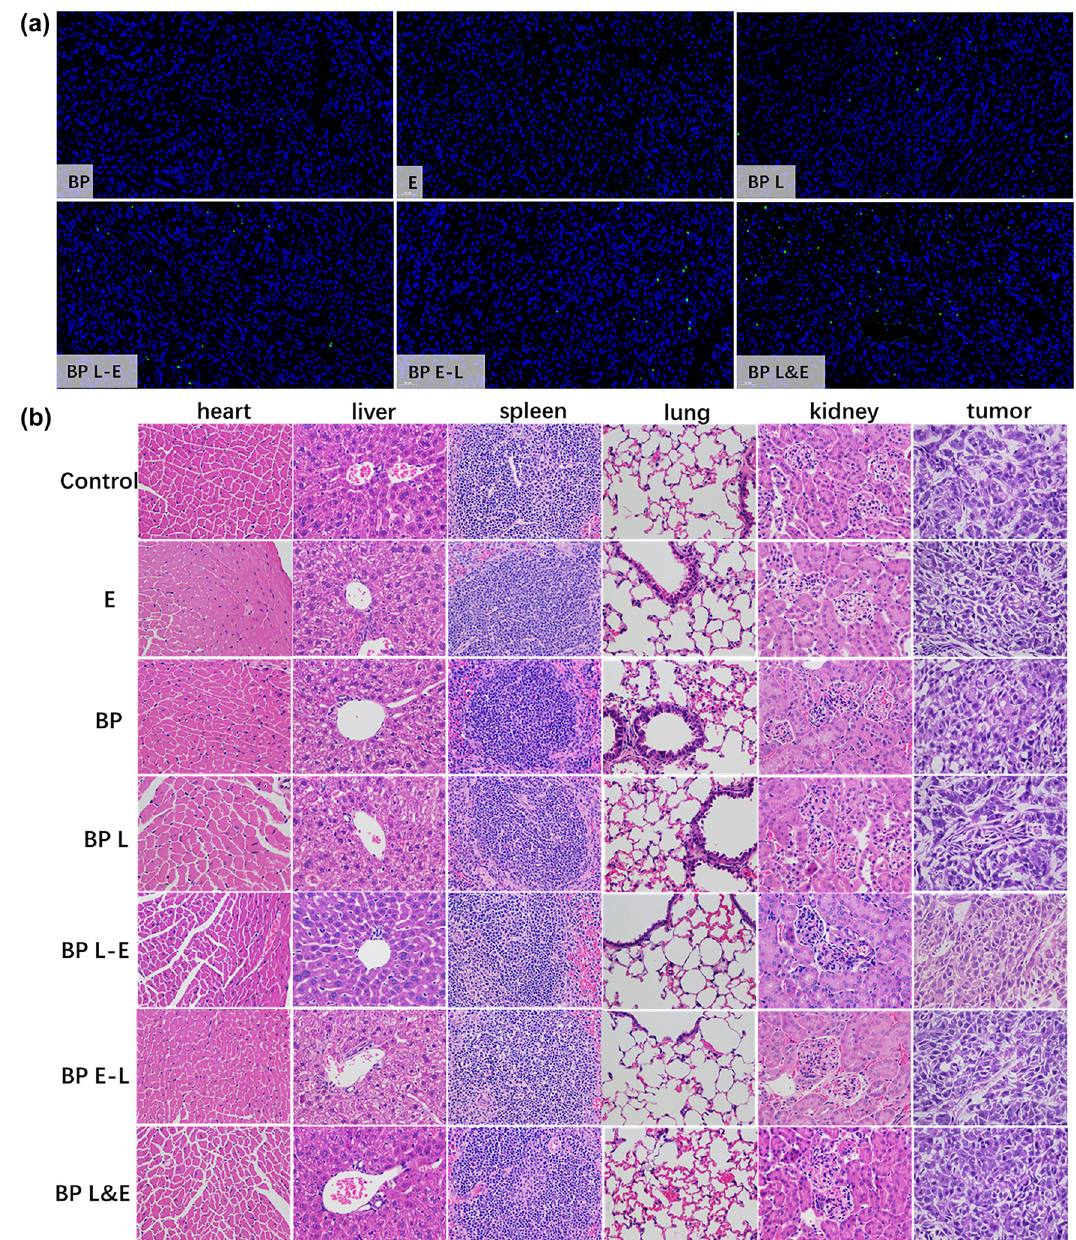
Figure 7: Immunohistochemistry and H&E analysis of all groups. (a) TUNEL analysis for tumor tissue sections of treated groups at 21 days, (b) H&E stained histological images of major organs and tumor tissue sections after 21 days.